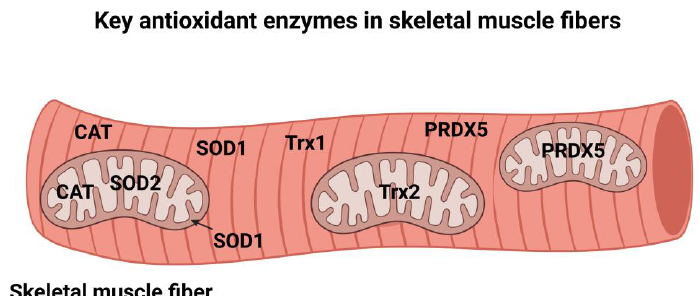
Figure 2. Cellular locations of key antioxidant enzymes in skeletal muscle fibers. See text for specific details. Key: SOD1 = superoxide dismutase 1; SOD2 = superoxide dismutase 2; GPX= glutathione peroxidase; CAT = catalase; Trx1 = Thioredoxin 1; Trx2 = Thioredoxin 2; PRDX5 = Peroxiredoxin 5. Figure created by